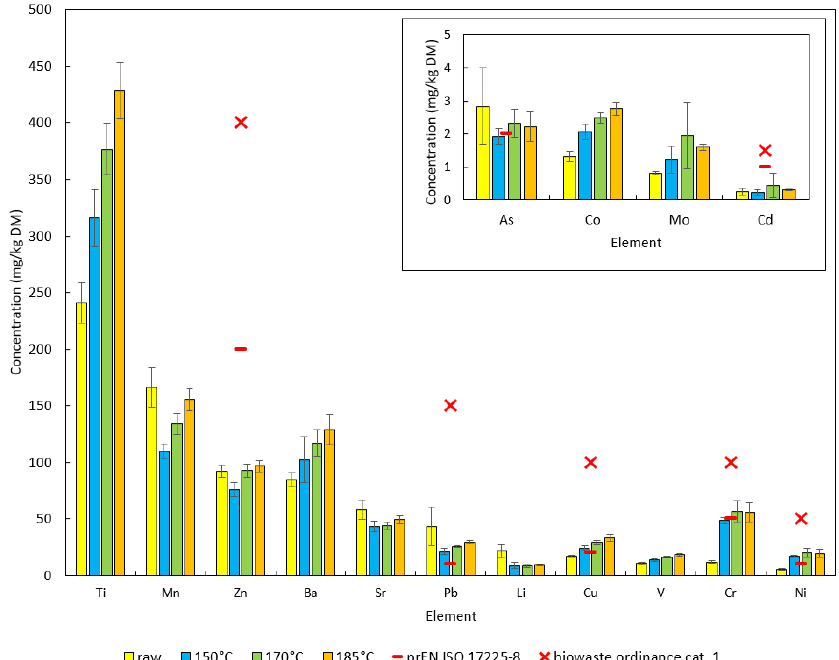
Figure 3. Mean values ± standard deviation of raw and treated (biochars) organic fraction of mu- nicipal solid waste (OFMSW) for elements with concentrations >1000 mg/kg dry matter (DM) and legal limits for fuels according to prEN ISO 17225-8:2016 [46].